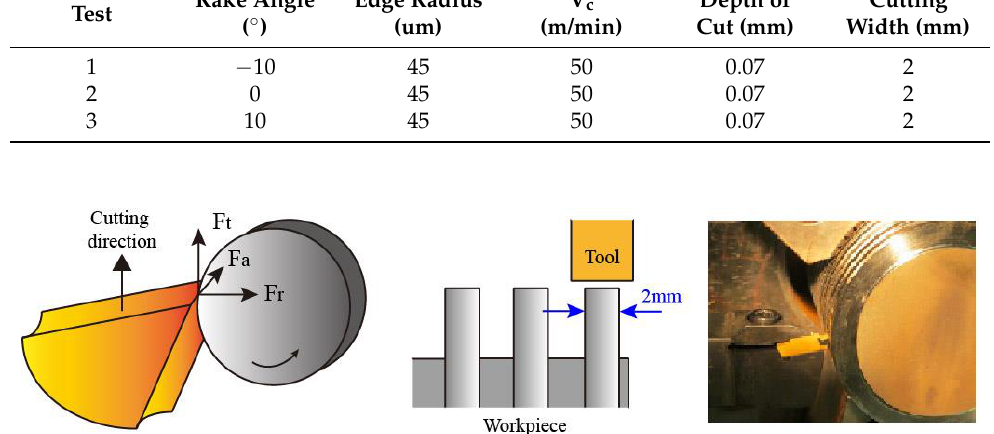
Figure 2. Employed orthogonal cutting test arrangement with customized tool inserts.